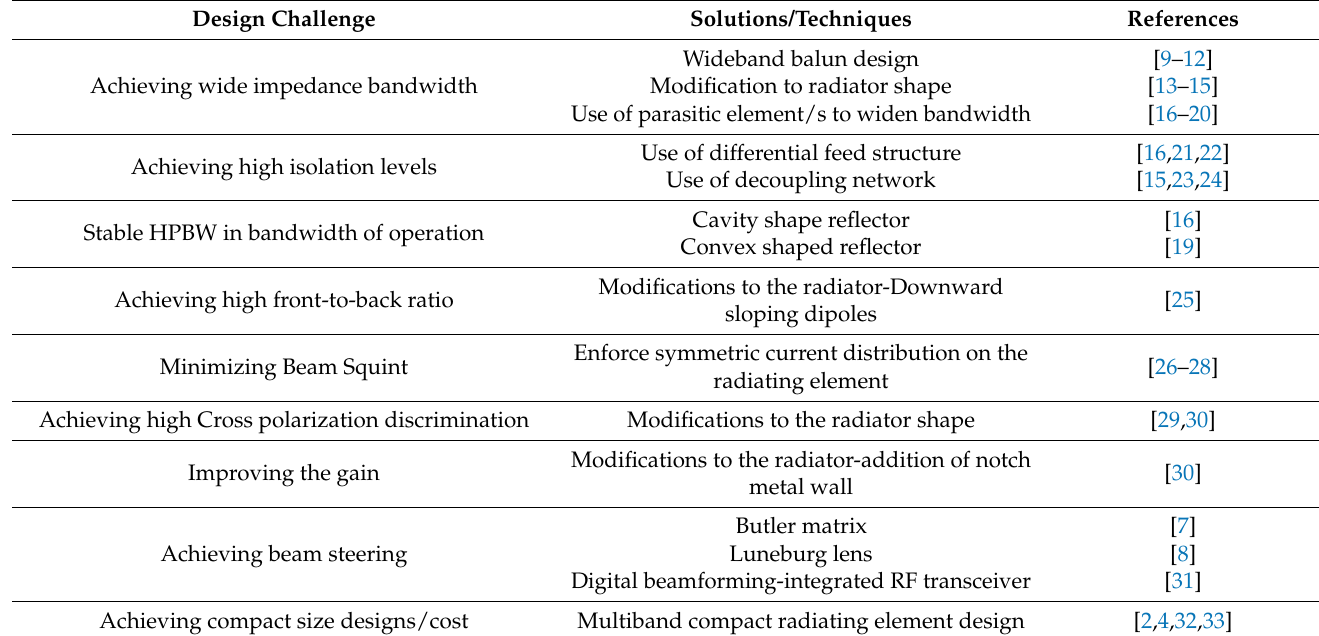
Table 1. A summary of available solutions for design challenges in Base Station Antenna design.